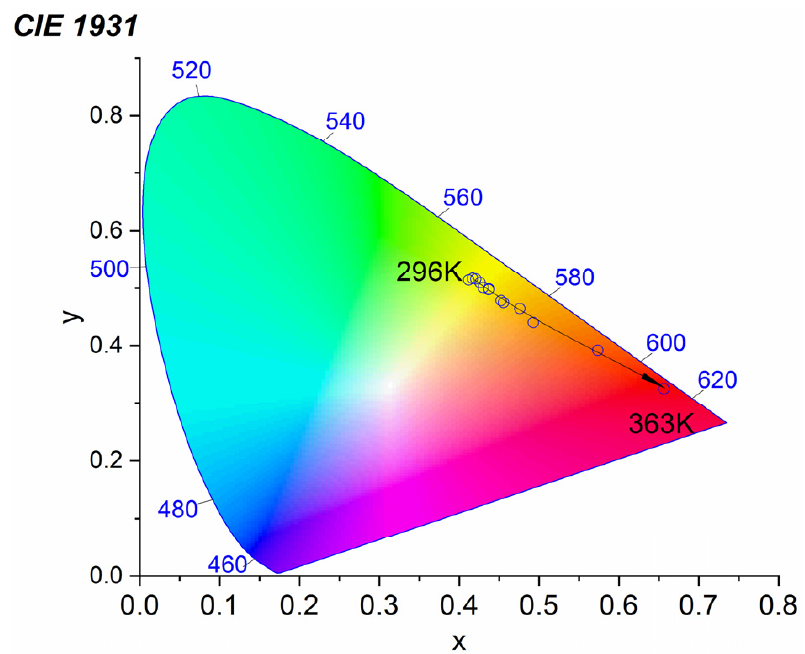
The films demonstrate luminescence color changes in the temperature range of 296–363 K. Therefore, they are promising colorimetric thermometers for in situ tempera- ture measurements (Figure 6 and Figure S3). The coordinates at the CIE diagrams were calculated using the respective emission spectra from 296 K to 363 K. The luminescence color of the film changes from yellow (X = 0.411, Y = 0.514) at 296 K to red (X = 0.656, Y = 0.325) at 363 K (Figures 7 and S3).